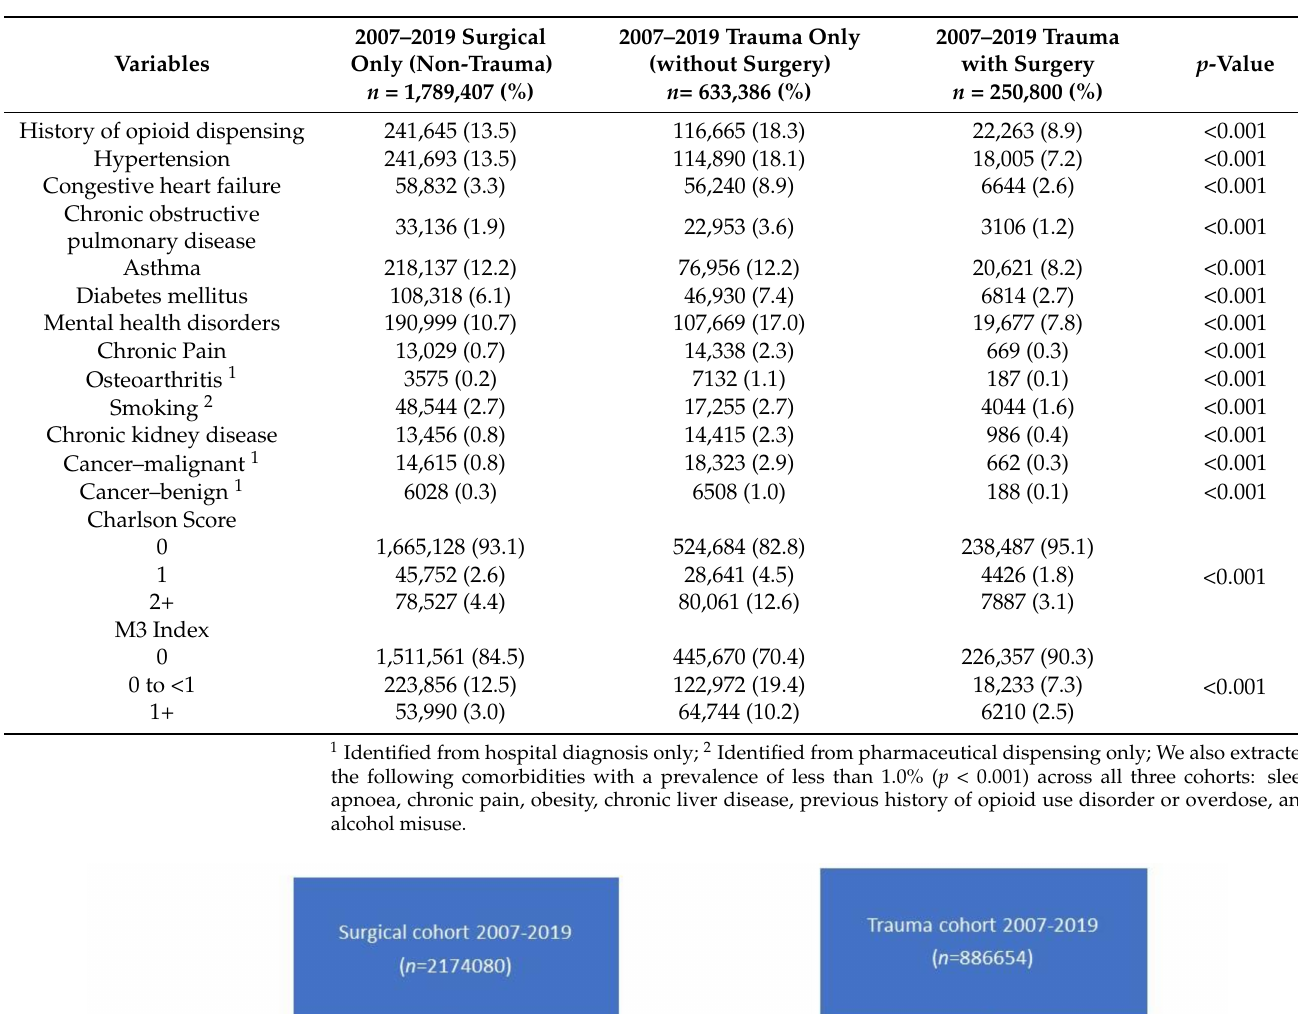
Table 2. Comorbidities and prior opioid use.